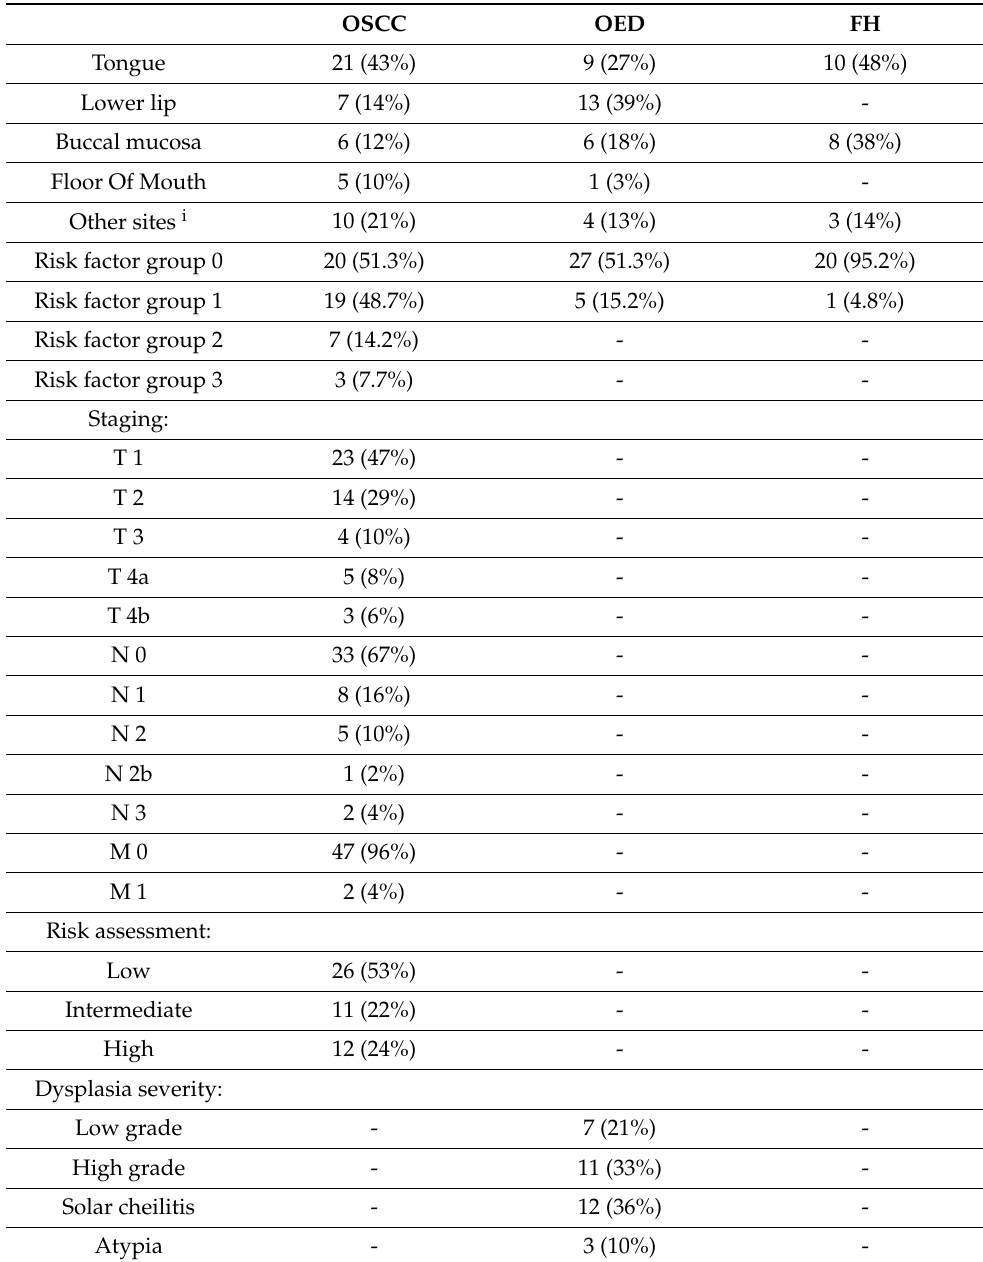
Table 2. Study groups sites of the lesions, risk factor data, staging, grading, and OED dysplasia severity. OSCC OED